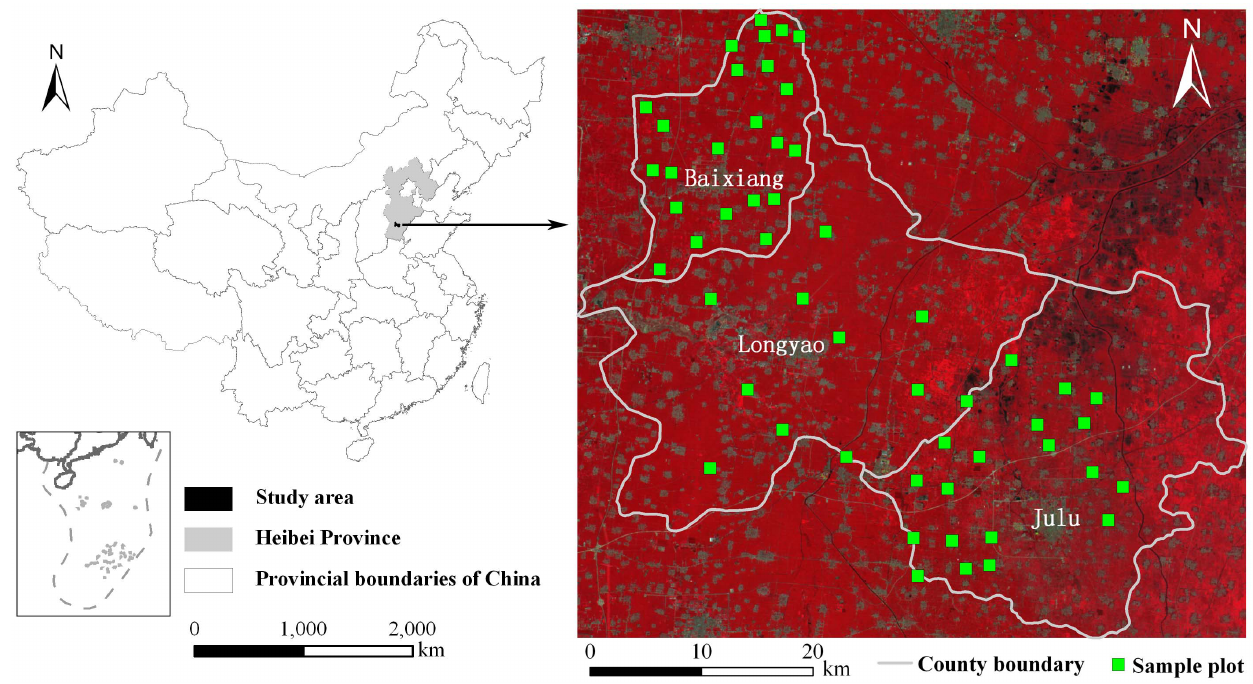
Figure 1. Spatial location of the sample plots for field experiments in three counties in North China. The box in the bottom left corner of Figure 1 shows the South China Sea islands.